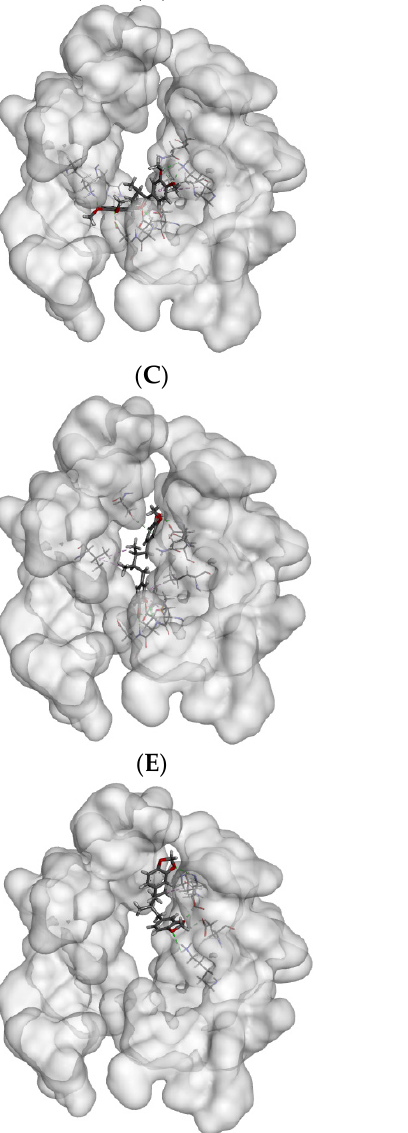
Figure 2. Molecular docking results of isolated compounds 1 – 3 against human TSLP in complex with TSLPR and interleukin-7 receptor α chain (IL-7R α ): ( A ) three-dimensional (3D) docking image of compound 1 ; ( B ) two-dimensional (2D) docking image of compound 1 ; ( C ) 3D docking image of compound 2 ; ( D ) 2D image picture of compound 2 ; ( E ) 3D docking image of compound 3 ; ( F ) 2D docking picture of compound 3.